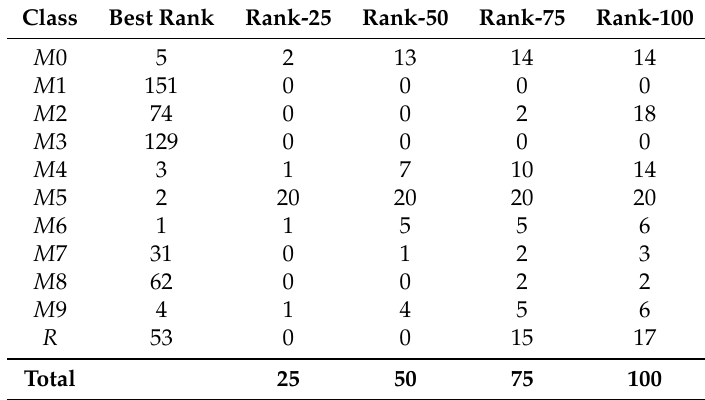
Table 3. Rank of models. Ranks